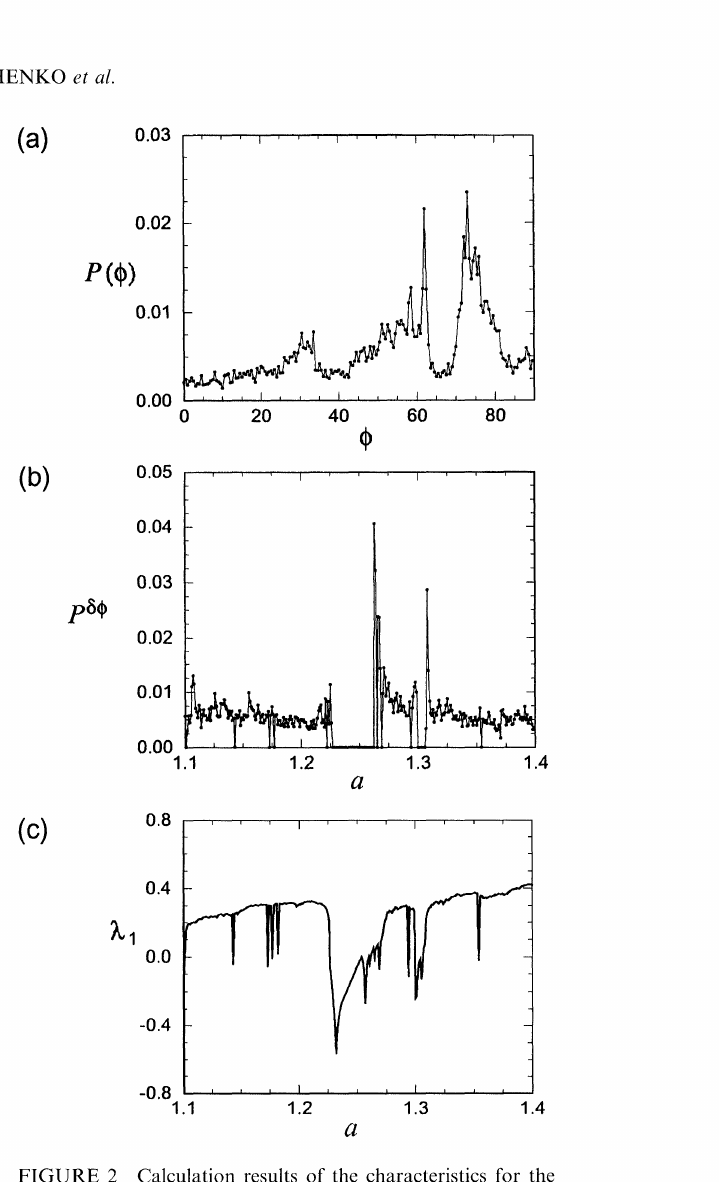
FIGURE 2 Calculation results of the characteristics for the Henon attractor (a) A distribution of the probabilities of the angle 0 between stable and unstable manifolds for a 1.179 and b=0.3, (b) the probability that the angle 0 falls within the interval 0 < 0_< 1 (0 1) versus parameter a for b=0.3 and (c) a dependence of the largest Lyapunov exponent on parameter a for b